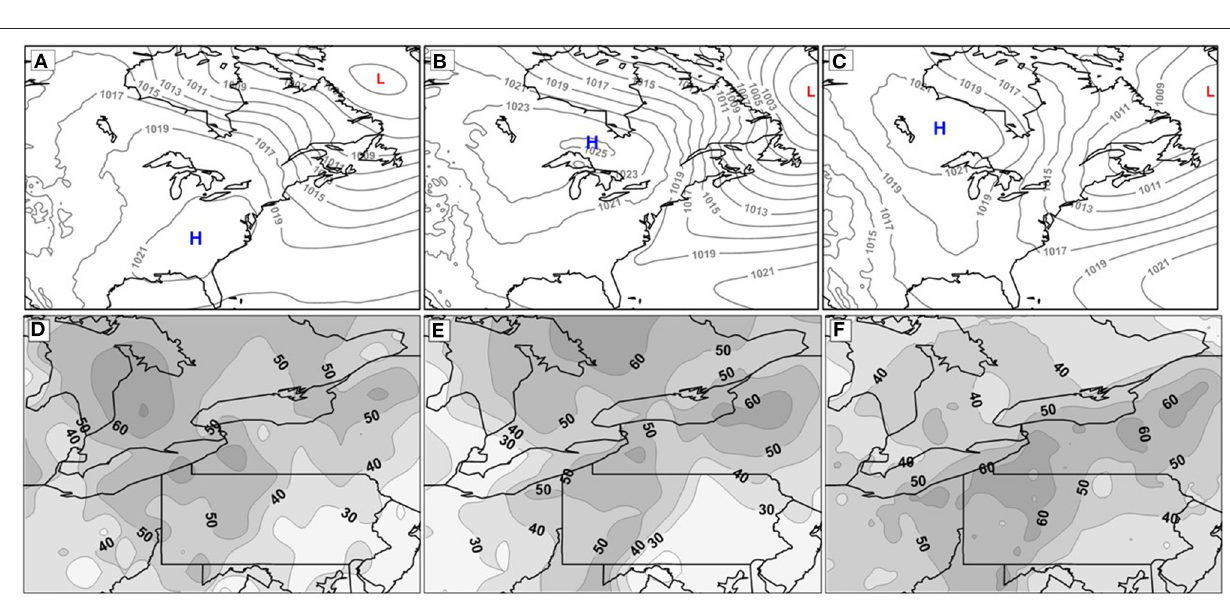
FIGURE 5 | Mean sea-level pressure (hPa) (A–C) and percentage of days with precipitation (D–F) for SSC-defined lake-effect days in early-season (left column), mid-season (middle column), and late-season (right column) uncorroborated by the TSI data set, 1964–65 through 2014–15. Isobars are in 2-hPa intervals, and percentage contours are in 10%